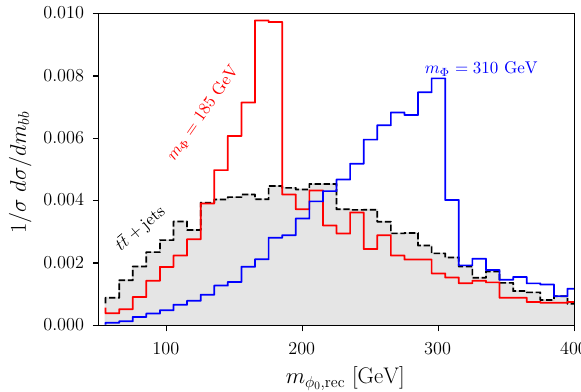
Fig. 10 Normalized distribution of m φ in the main background 0 , rec (dashed black) and in the signal for m (cid:2) = 185 GeV (solid red) and m (cid:2) = 310 GeV (solid blue)